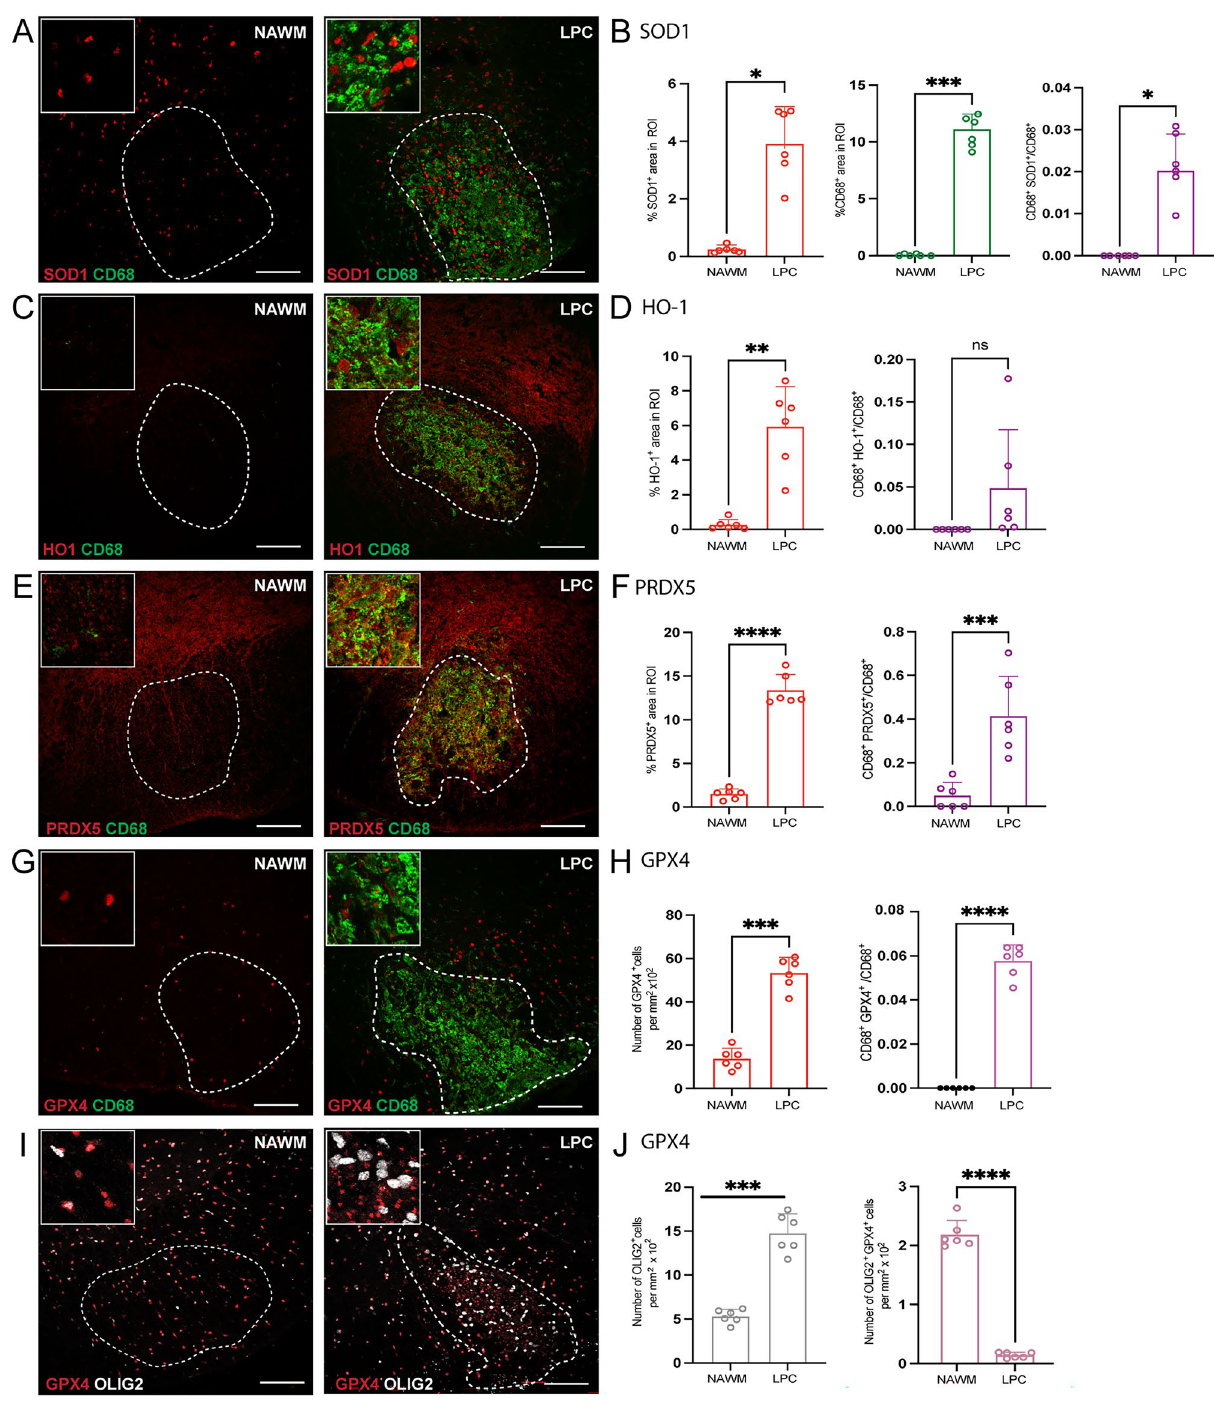
Figure 3. Expression of antioxidant enzymes is elevated in LPC-induced lesions. ( A , C , E , G , I ) Representative confocal images of NAWM or LPC injected mice labeled with CD68 for microglia/macrophage (green), antioxidant enzyme of interest (red), OLIG2 for oligodendrocyte lineage cells (white). Dotted line indicates the lesion ROI selected for image analysis. ( B , D , F ) Bar graphs comparing the percent of ROI that is CD68 + , antioxidant enzyme of interest, and CD68 + antioxidant enzyme + . ( H ) Bar graph comparing the number of GPX4 + cells per mm 2 × 10 2 of ROI and percent of ROI that is CD68 + GPX4 + ( J ) Bar graph representing number of OLIG2 + cells per mm 2 × 10 2 of ROI and percent of ROI that is OLIG2 + GPX4 + . Scale bar = 100 µm. Data are shown as mean ± S.D, n = 6 mice. Significance indicated as * p < 0.05, ** p < 0.01, *** p < 0.001, **** p < 0.0001, two- tailed, paired student’s